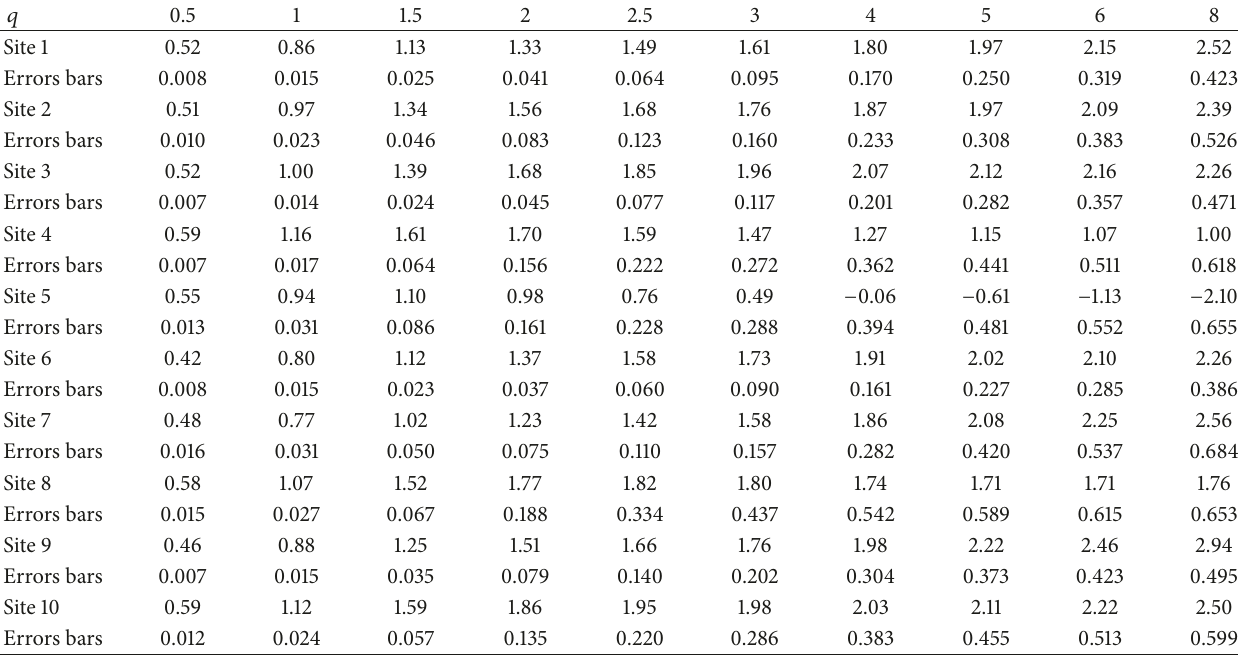
Figure 4: Testing for multiscaling. (a) Multiscale diagram. Compared with the alignment for FBM, hydrological data with no alignment suggests multiscale behaviour. (b) Linear multiscale diagram. The FBM series exhibits horizontal alignment. The errors bars are based on the weighted linear least square fit which is used to estimate 𝜁(𝑞) and reveal 95% confidence interval. Table 7: 𝜁(𝑞) for hydrological data of 10 sites; 𝜁(𝑞) is estimated with a sampling interval of 6min and (𝑗 1 , 𝑗 2 ) = (2,6)